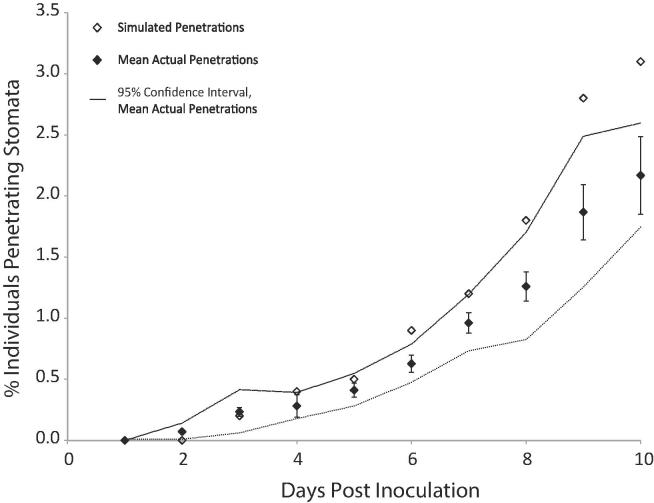
Occurrence of simulated and actual stomatal penetration events over 10 days. Fungal growth was modelled assuming random growth. Growth rate, probability of changing direction, branching, and following plant cell walls were estimated from images gathered for experiments described in Fig. 1, Fig. 2. Probability of penetrating encountered stomata was from published data. Simulated data are represented by open symbols. Closed symbols represent the means of three independent experiments in which Z. tritici was scored for penetration of stomata on leaf samples each day (see Fig. 4); error bars show SE and lines indicate upper and lower bounds of 95% confidence intervals of these means. Bonferroni corrected t-tests, using the simulated data point as a estimate of the population mean, were carried out where the simulated data point falls outside of these confidence intervals, but no significant results were obtained (6 dpi, P = 0.16; 8 dpi, P = 0.28; 9 dpi, P = 0.20 and 10 dpi, P = 0.10).